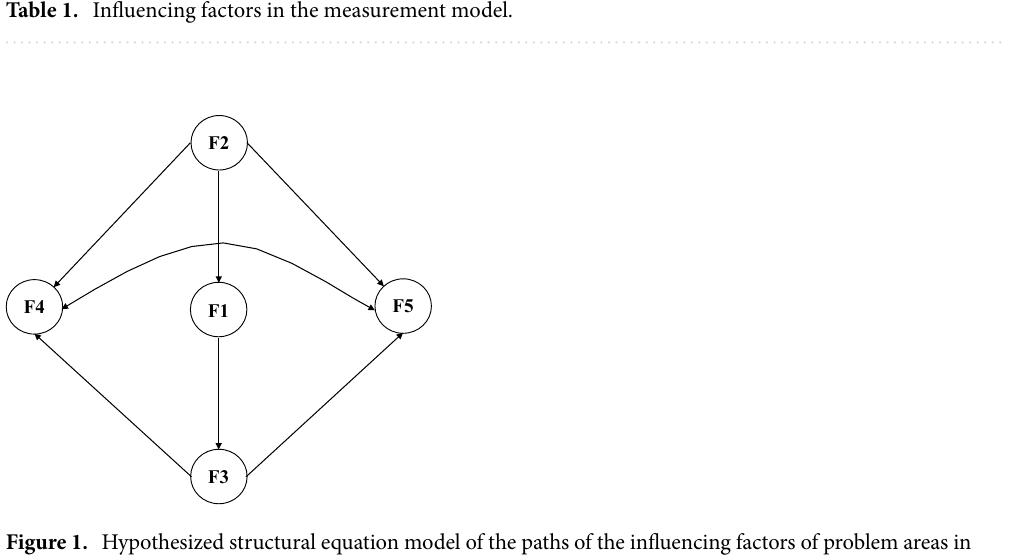
Table 1. Influencing factors in the measurement model.